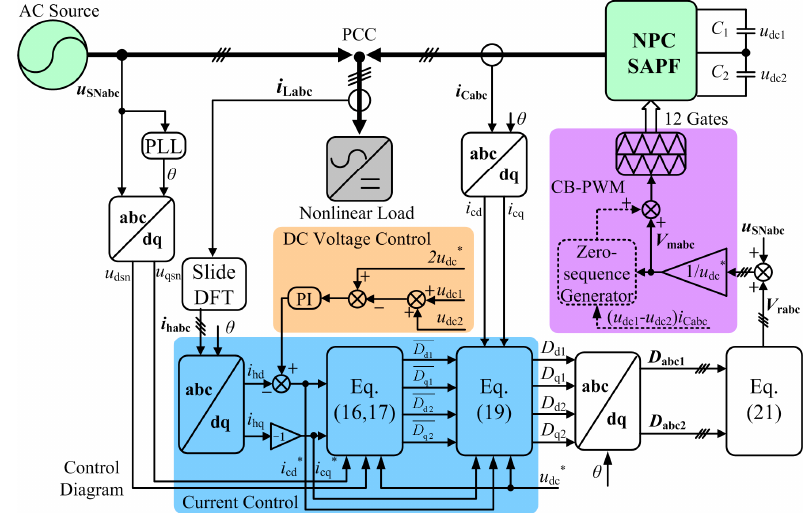
Figure 2. Block diagram of the proposed control strategy. PCC: point of common coupling; PLL: phase lock loop; CB-PWM: carrier based pulse width modulation; and DFT: discrete Fourier transformation. In Figure 2, u SNabc represents three phase PCC voltages. θ is the phase of PCC voltages, which is estimated from the phase lock loop (PLL). i Labc represents three phase load currents. i habc represents three phase harmonic currents. i Cabc represents three phase output currents. i * from i Labc by slide discrete Fourier transformation (DFT) in SRF. u *